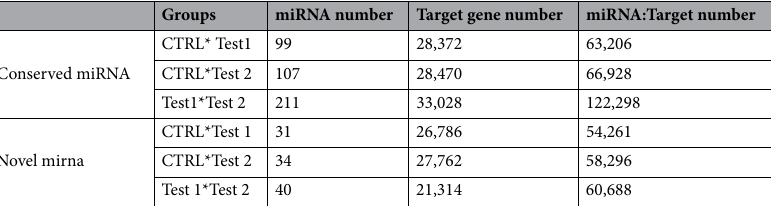
Table 4. Numbers of differentially expressed conserved and novel miRNAs and their targets among the three libraries of Control (CTRL), Test 1 and Test 2.